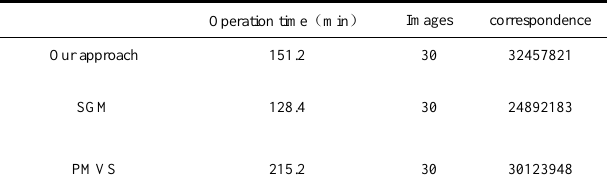
Table 2.The operation time of each